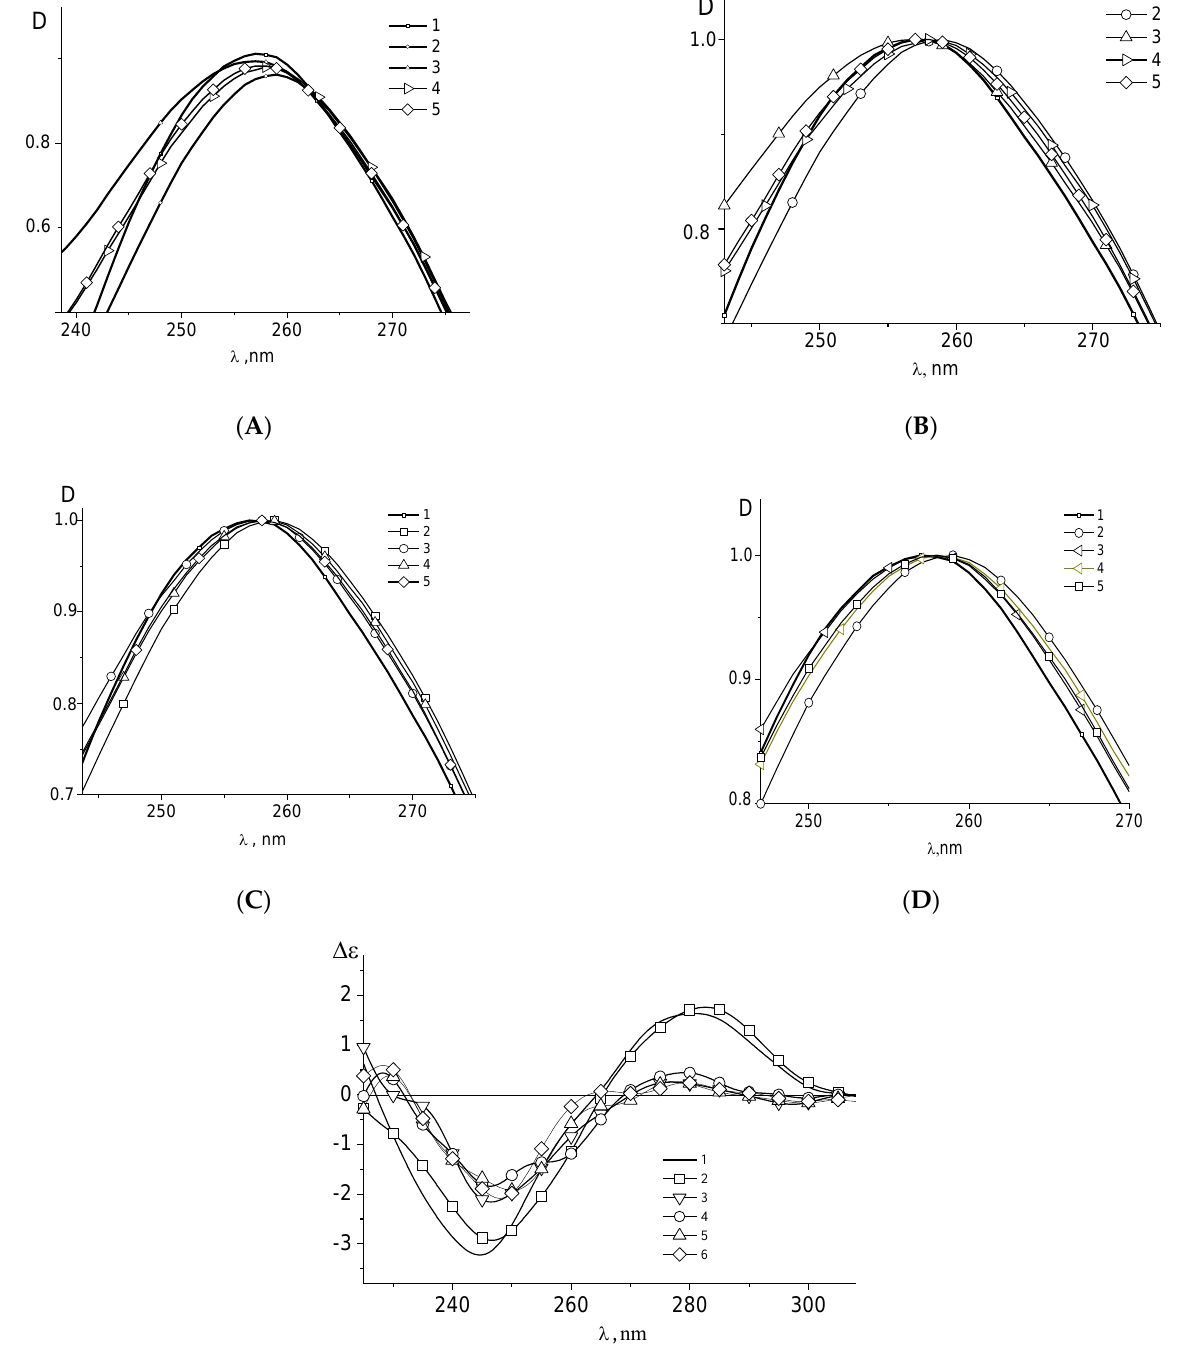
Figure 9. UV ( A – D ) and CD ( E ) DNA spectra (1) and normalized DNA spectra in complexes with cis-DDP (2), with biplatinum compounds, bi-Pt (3), in complexes DNA + cis-DDP + bi-Pt (4) and DNA + bi-Pt + cis-DDP (5). The absorption spectra in complexes with Pt1 ( A ) and normalized absorption spectra in complexes with Pt1 ( B ), Pt2 ( C ), Pt3 ( D ) and CD spectra of DNA in the test experiment for the competition between cis-DDP and Pt4 for the binding site on a DNA molecule in a 0.005 M NaCl: ( C ) (bi-Pt) = 3 × 10 −5 M. Explanations in the text.